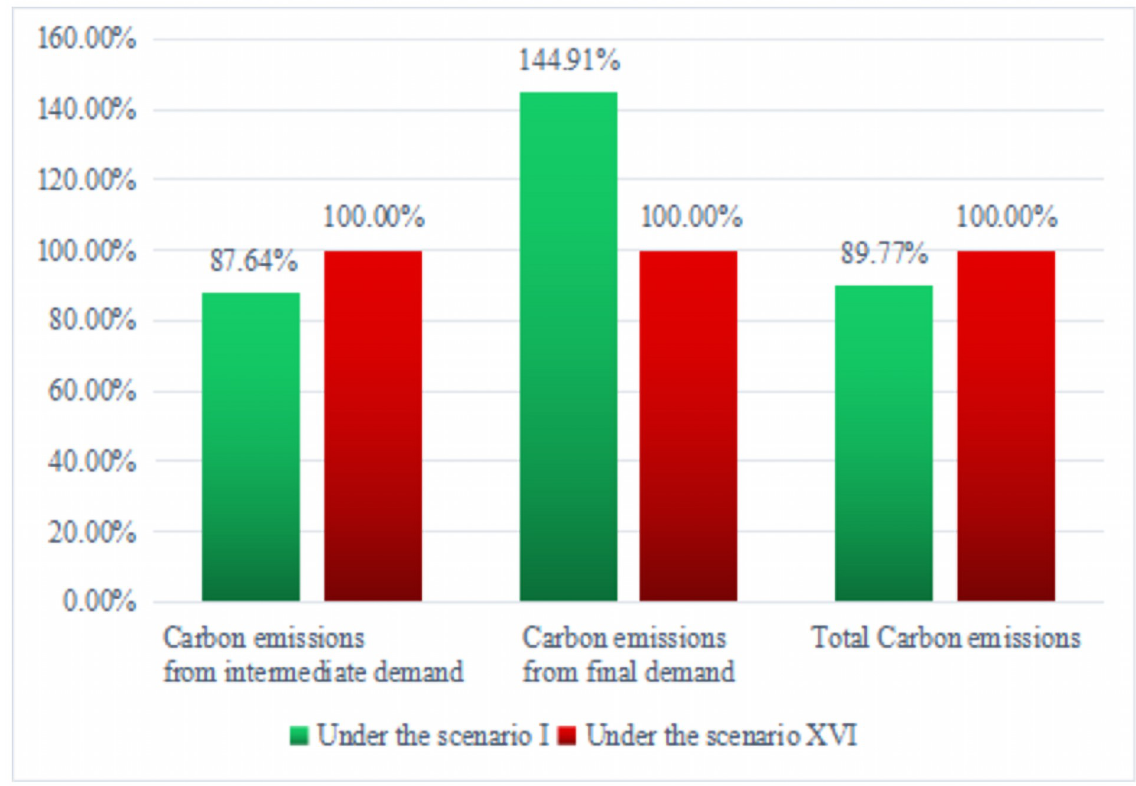
measured, and the results are shown in Table 3.